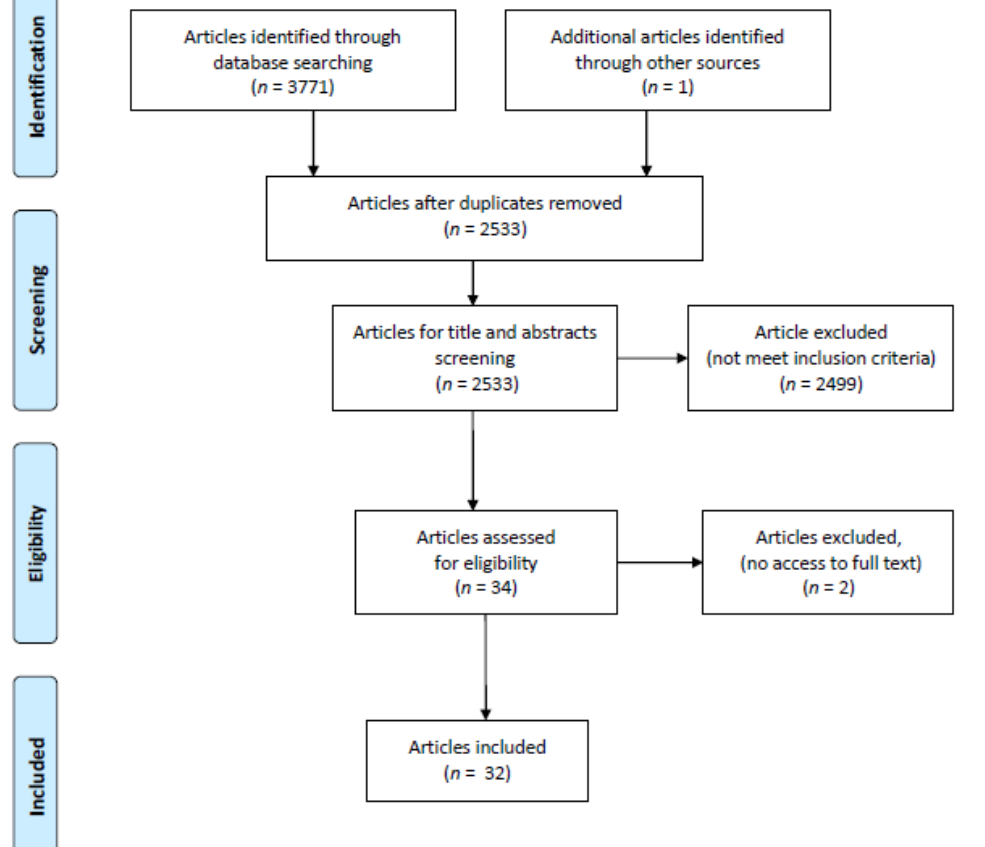
Figure 1. Literature search flow diagram.